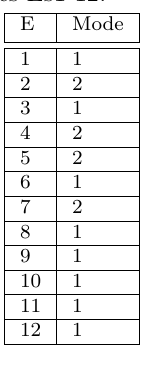
Table 5: The table shows the chosen model reduction modes (Eq. (11)) in the δ -PRC method for the examples Es1-12.